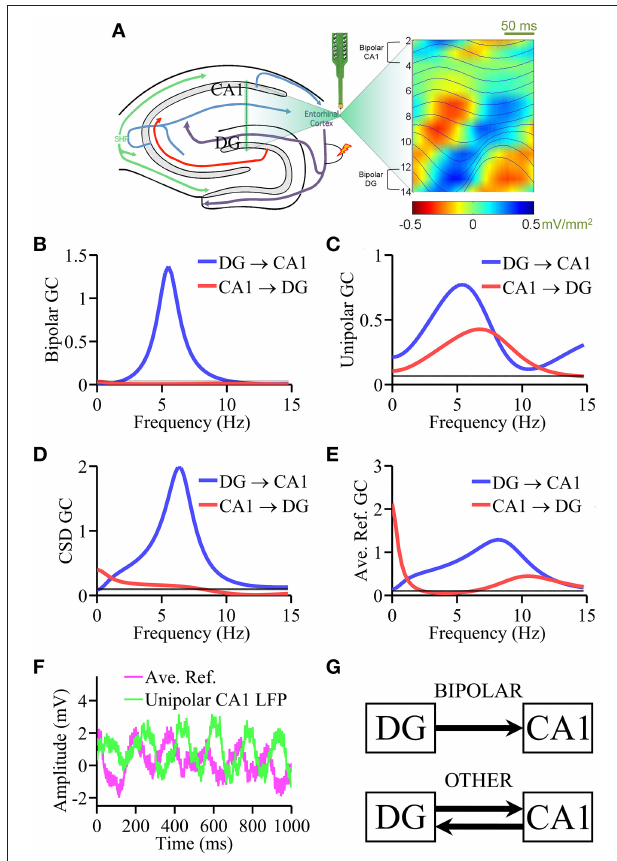
FIGURE 2 | Laminar recording from rat hippocampus. (A) Schematic of the multielectrode with 16 equally spaced (100 µ m) contacts and theta generators as identified by phase realigned and averaged (PRAT) CSD (color-coded) and LFPs (smooth traces, blue). Granger causality spectral analysis using (B) bipolar data, (C) unipolar data, (D) CSD data, and (E) average re-referenced data. (F) Comparison of unipolar LFPs from CA1 and average reference signals. (G) Schematic summarizing the Granger causality results where “OTHER” includes unipolar data, average re-referenced data and CSD data. Bipolar results are in agreement with ground truth. Black horizontal lines in (B–E) represents the level of statistical significance ( p < 0.05